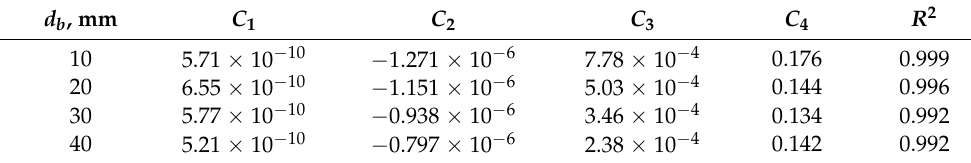
Table 4. The C 1 – C 4 coefficients from Equation (16), depending on the bar